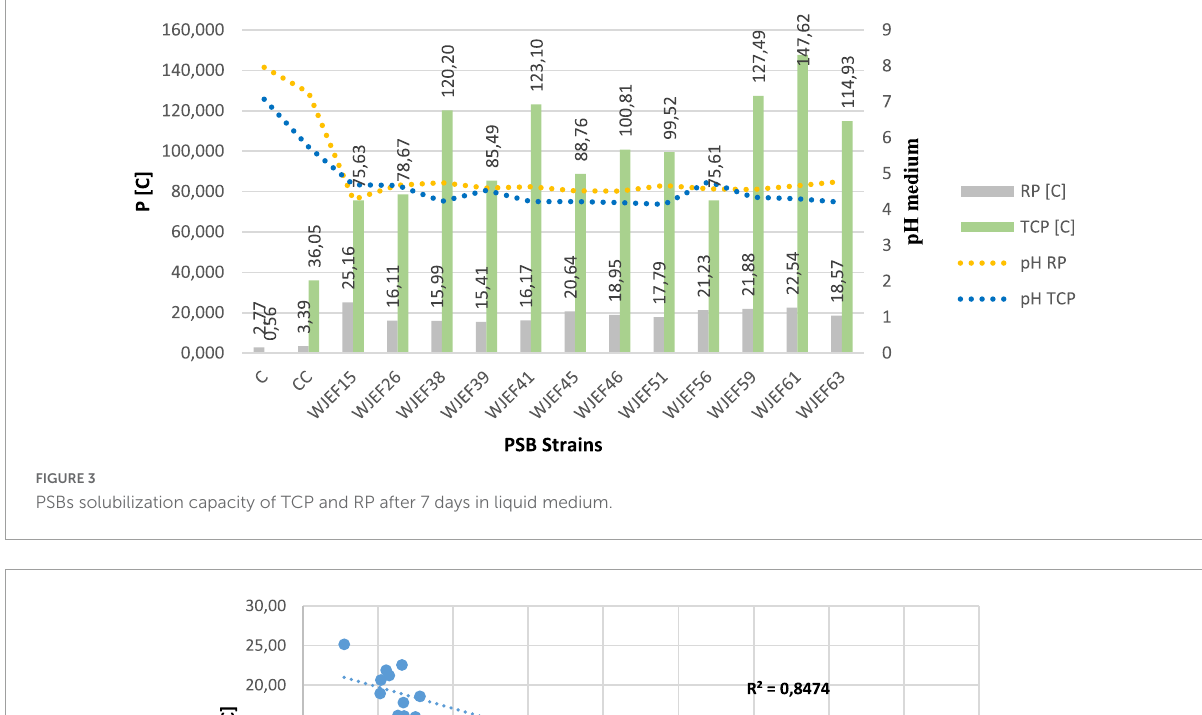
FIGURE4 Negative correlation between pH medium and solubilization